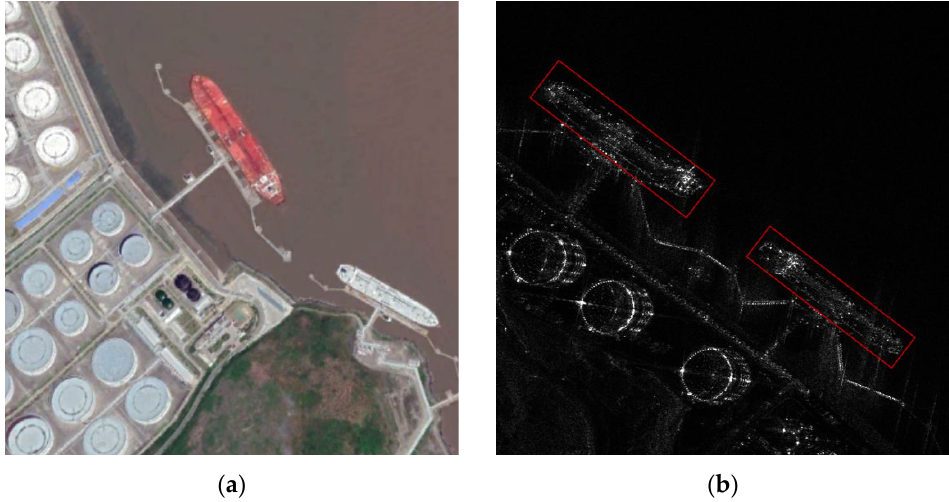
Figure 4. Comparison of the optical image and the SAR image: ( a ) optical image; ( b ) SAR image.